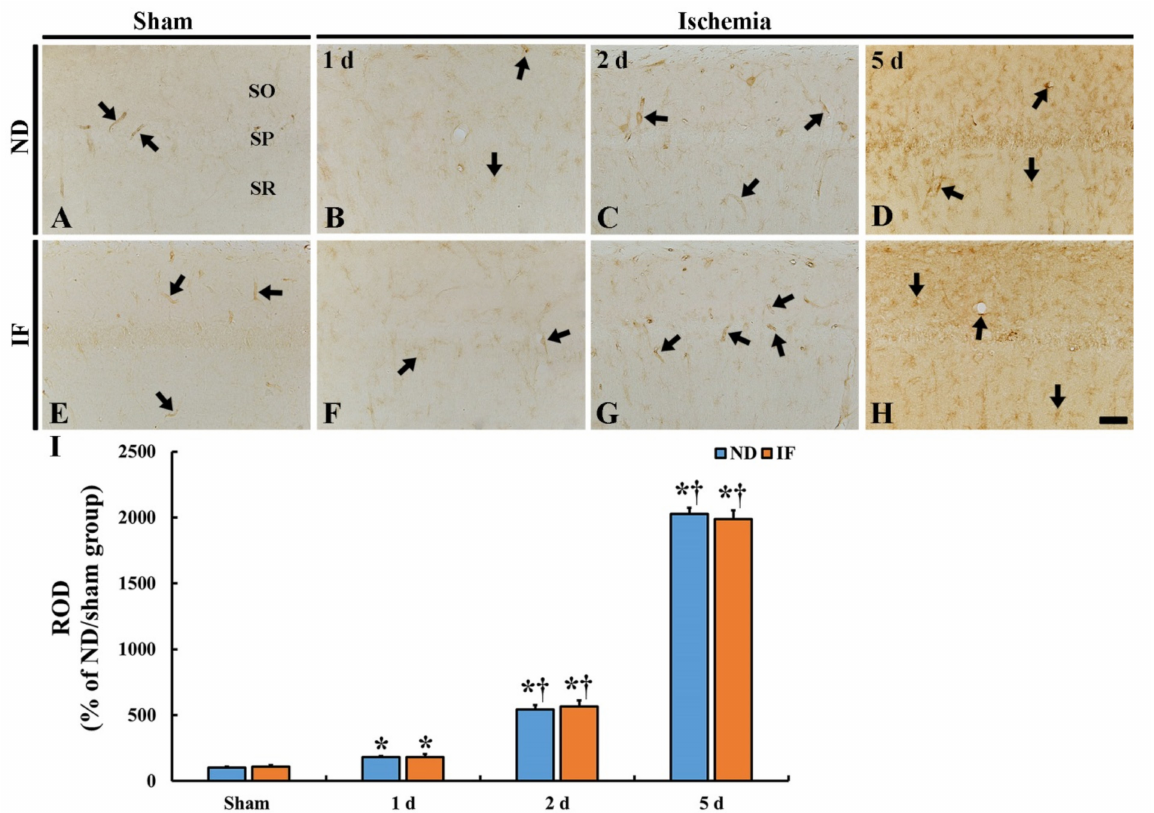
Figure 8. Immunoglobulin G (IgG) immunohistochemistry in the CA1 region of the ND (upper column) and IF (lower column) groups at sham ( A , E ), 1 day ( B , F ), 2 days ( C , G ) and 5 days ( D , H ) after ischemia. In the two groups, IgG immunore- activity is significantly increased with time after ischemia, showing that there is no difference in the immunoreactivity between the two groups. Scale bar = 50 µ m. ( I ) Relative optical density (ROD) of IgG immunoreactivity as percent values in the CA1 region ( n = 7 in each group, * p < 0.05 vs. ND/sham group, † p < 0.05 vs. pre-time point group of each group by post hoc Tukey’s test). Bars indicate the means ± SEM. IF, intermittent fasting; ND, normal diet; SO, stratum oriens; SP, stratum pyramidale; SR, stratum